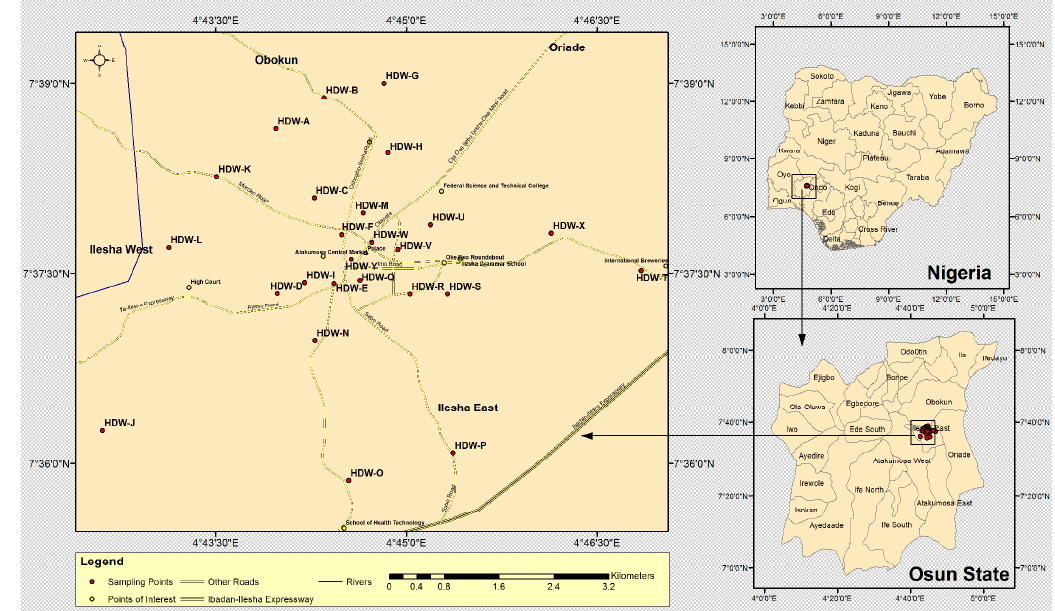
Fig. 1. Map of Ilesa metropolis showing the investigated sampling